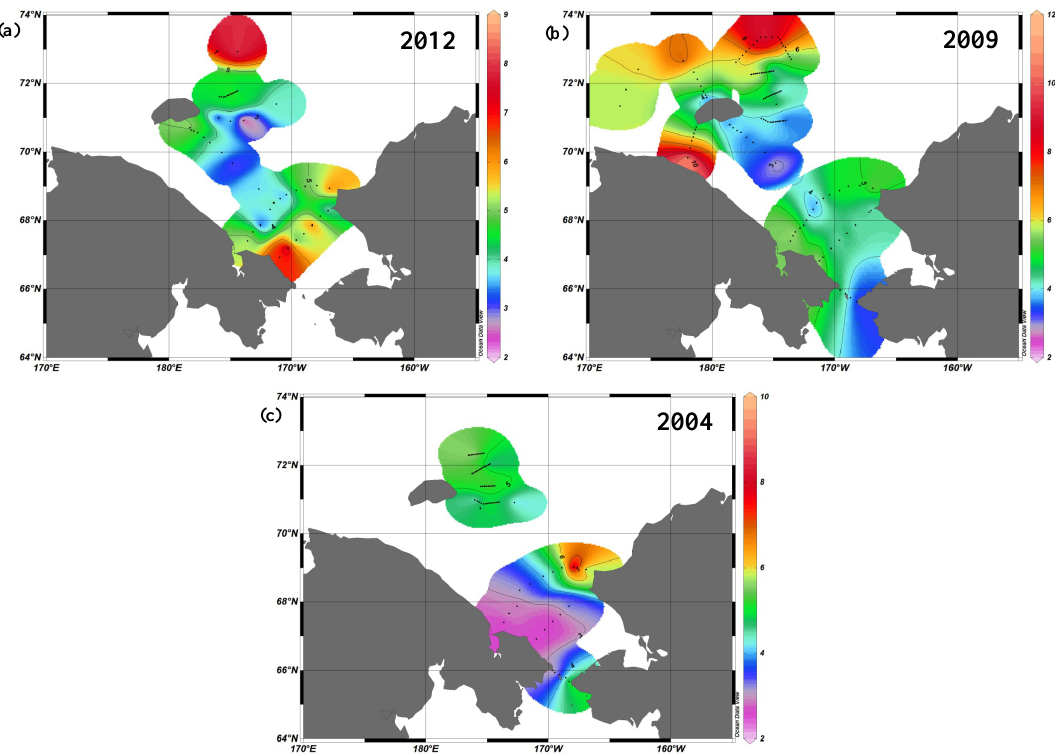
Figure 7. The distributions of Fresh Water Content (FWC in m) in the Chukchi Sea in 2012 (a) , 2009 (b) , and 2004 (c)